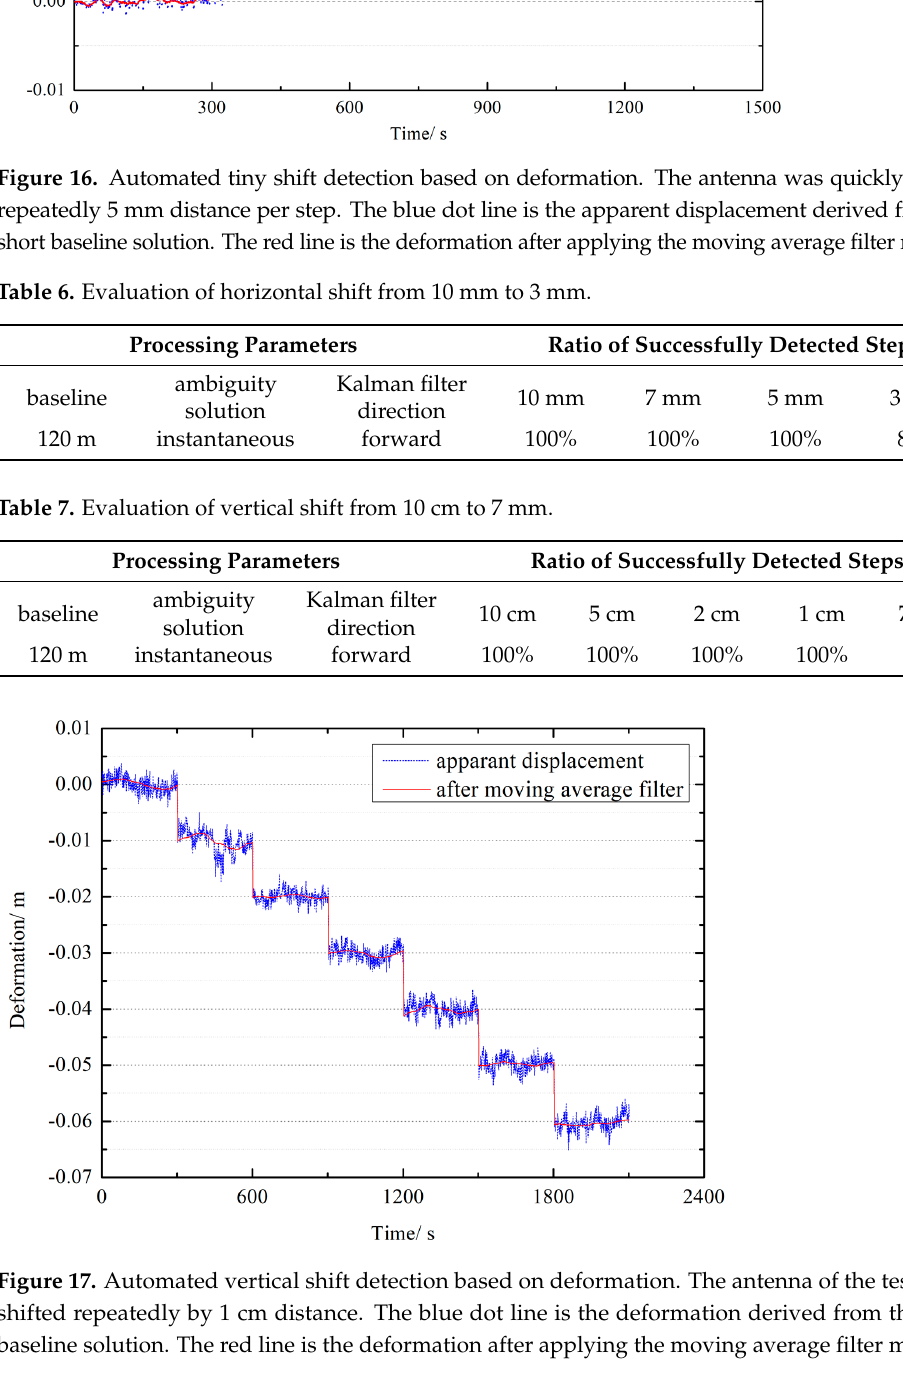
100% Table 6. Evaluation of horizontal shift from 10 mm to 3 mm. Processing Parameters